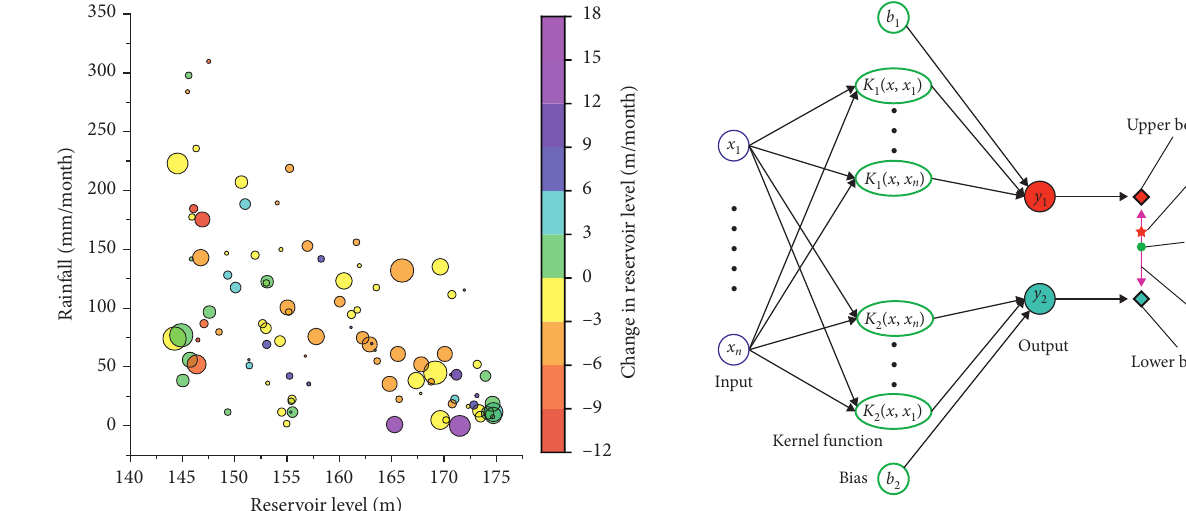
Figure 8: LSSVM model used to estimate the lower and upper bounds of the PIs in the LUBE method. ( K ) 1 and ( b ) 1 represent the kernel function and bias of the first LSSVM model, respectively; ( K ) 2 and ( b ) 1 represent the kernel function and bias of the second LSSVM model, respectively; the outputs ( y ) 1 and ( y ) 1 generated by the two LSSVM models correspond to upper and lower bounds of future unknown displacement,